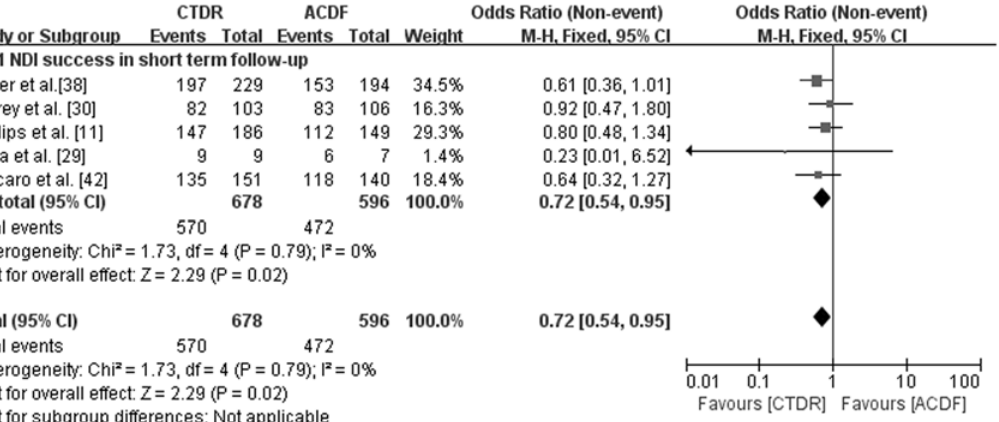
Fig 4. Comparison of NDI success between the cervical total disc replacement (CTDR, experimental) group and the fusion (ACDF, control) group in short-term follow-up. MH = Mantel-Haenszel, CI = confidence interval, and df = degrees of